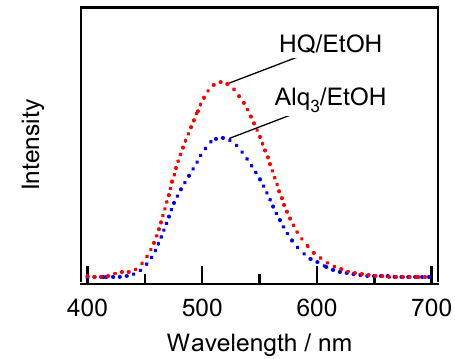
Figure 9. Fluorescence spectra obtained for the residual solutions of 1 mM Alq 3 /EtOH and HQ/EtOH after dipping and removal of the APA plates (v). The excitation wavelength was 380 nm.